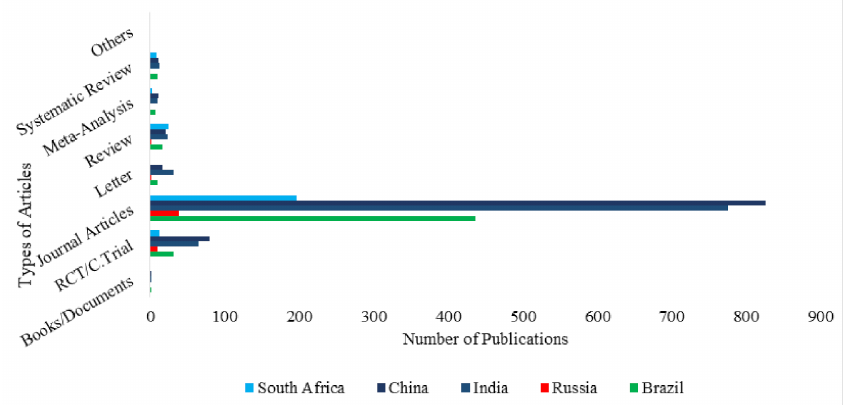
Figure 6. Article types: comparison among BRICS